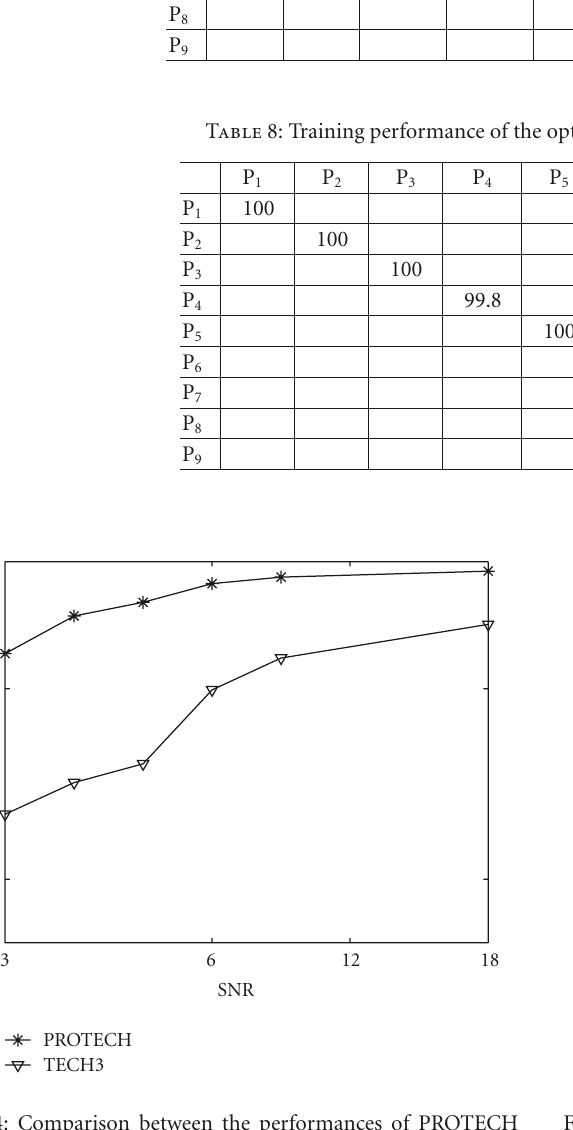
Figure 4: Comparison between the performances of PROTECH and TECH3.